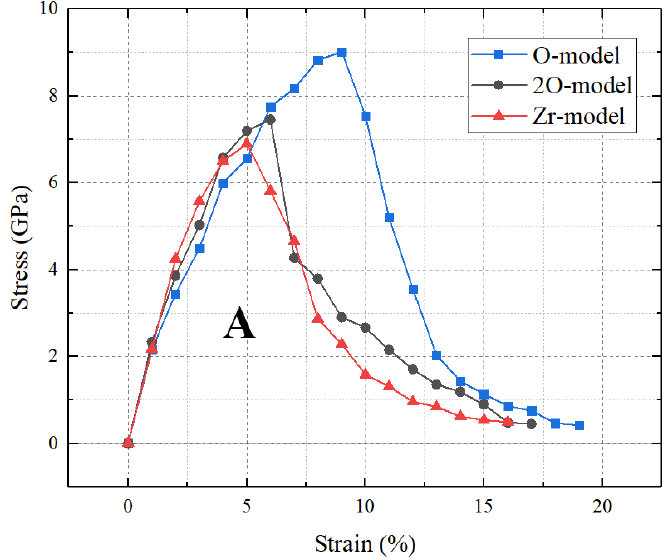
02) interfaces. The ̄